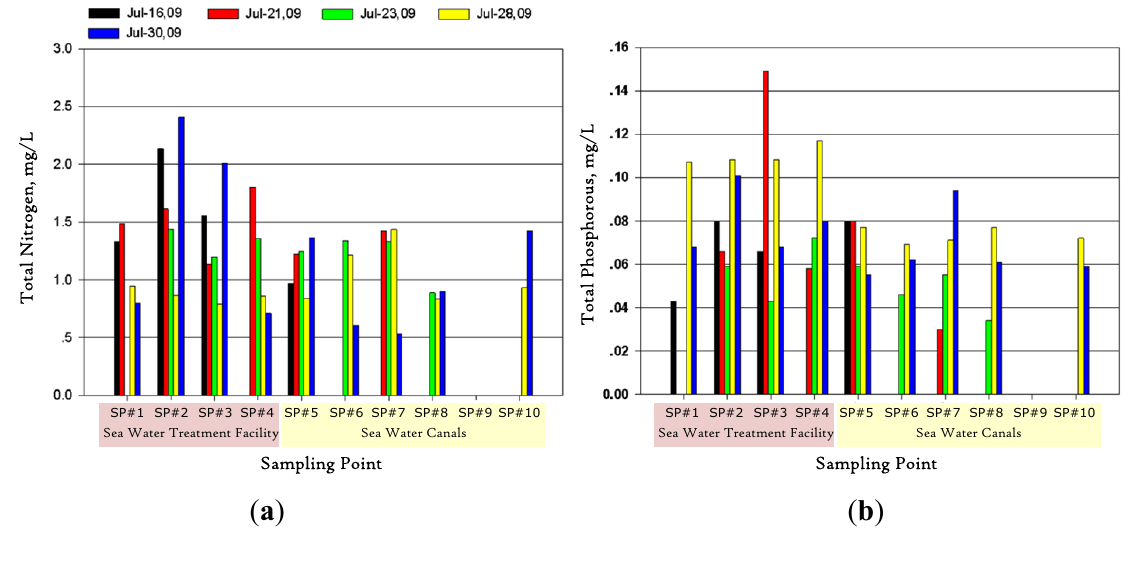
Figure 5. Monitoring results of ( a ) T-N; and ( b )